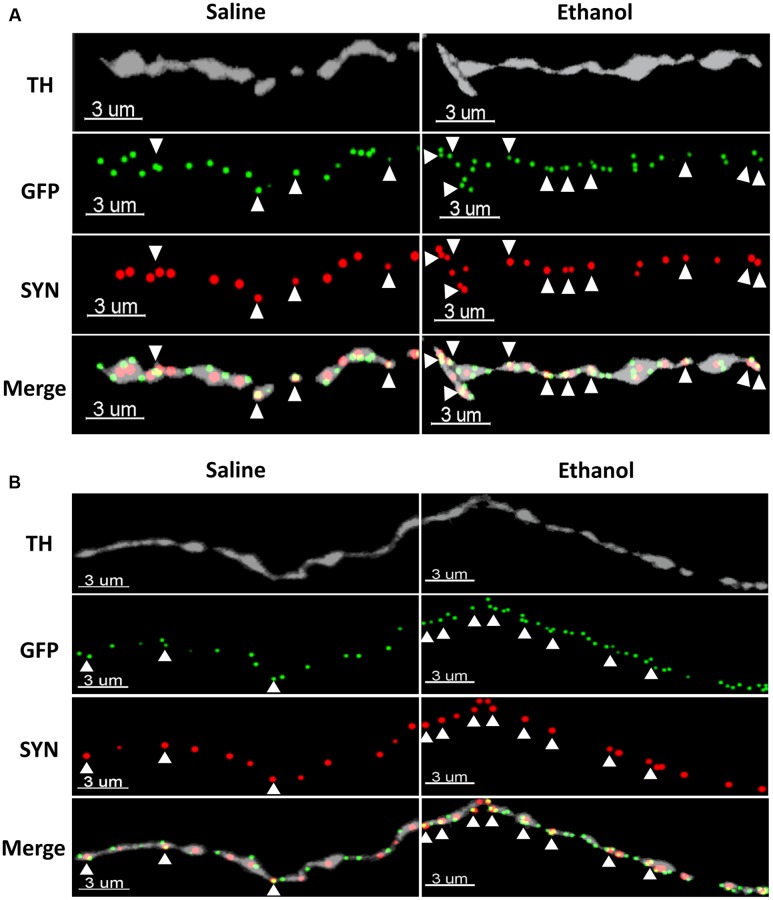
Representative micrographs showing the ethanol-induced upregulation of α4-YFP puncta within the synaptic boutons of dopaminergic terminals in the NAc (A) and the BLA (B). The top horizontal panel shows a TH immunolabelled axon (grey), followed by the anti-GFP (YFP) staining of α4 receptor puncta (green) and synaptophysin puncta (red). The bottom horizontal panel shows the merge of upper panels. White arrowheads show synaptophysin puncta co-localised with one or more α4 receptor puncta (yellow). Scale bar: 3 μm.